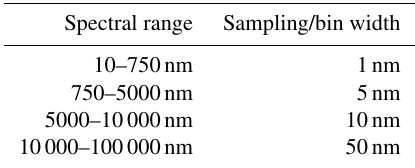
Table B1. Sampling and bin width of CMIP6-SSI. Spectral